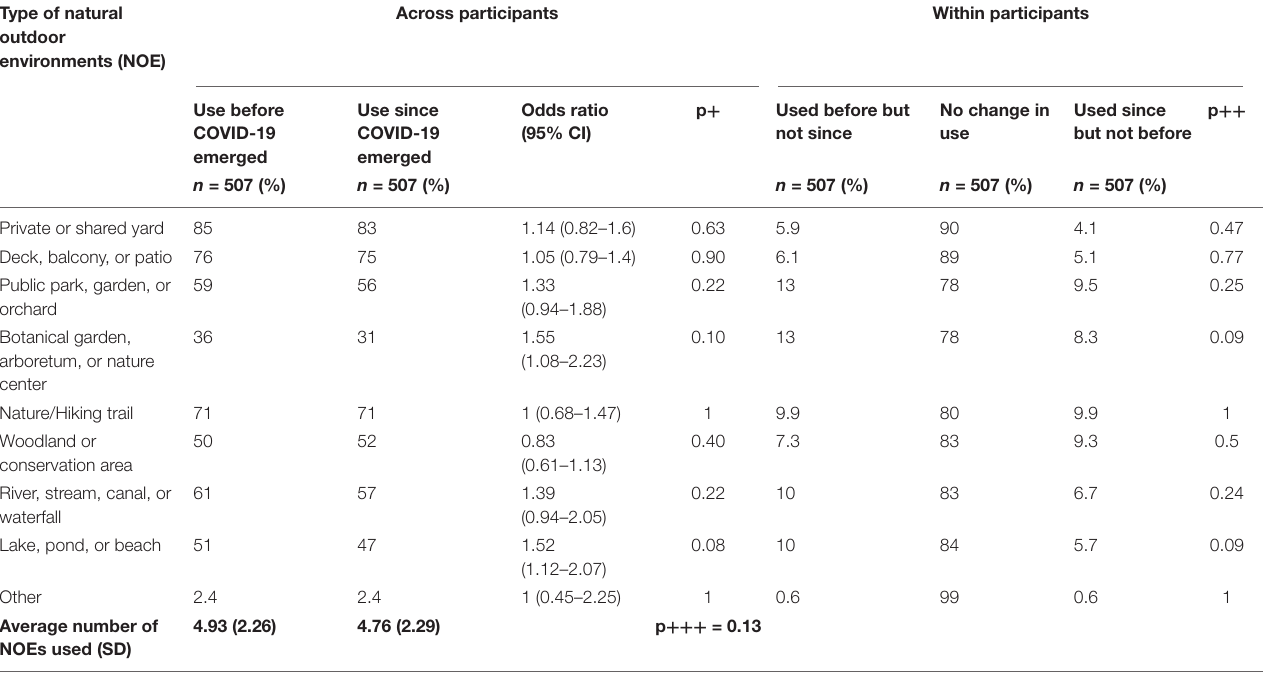
TABLE 4 | Changes in the use of natural outdoor environments